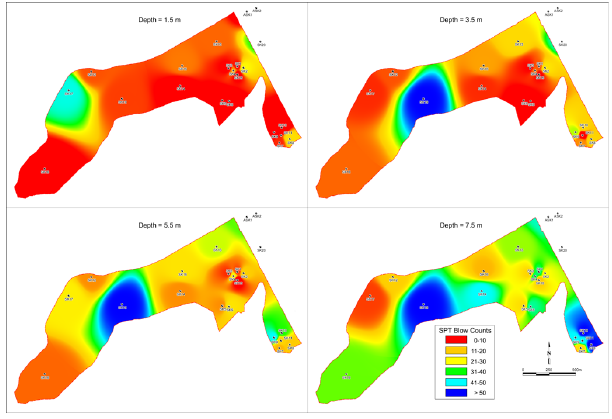
Fig. 10. SPT zonation maps performed in the study area.